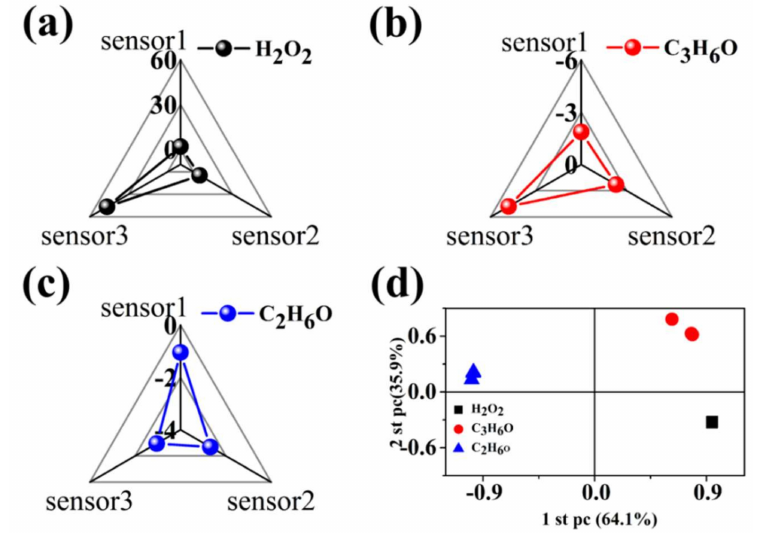
Figure 7. Fingerprints combining kinetic and thermodynamic parameters of ( a ) H 2 O 2 , ( b ) C 3 H 6 O, ( c ) C 2 H 6 O; ( d ) Two-dimensional principal component analysis (PCA) plots according to the responses to H 2 O 2 , C 3 H 6 O, and C 2 H 6 O of sensor